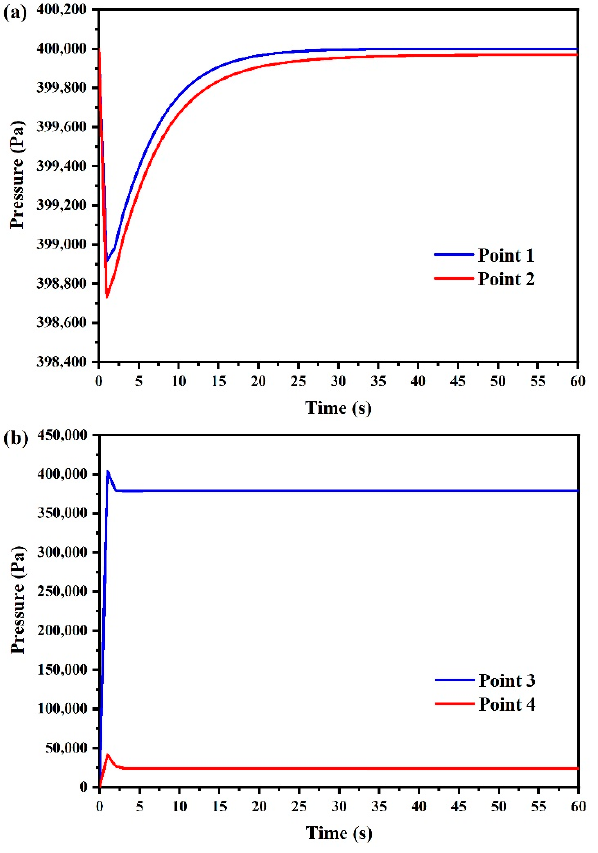
Figure 4. ( a ) Pressure distribution curves of monitoring points inside the pipeline. ( b ) Pressure distribution curves of monitoring points outside the pipeline.